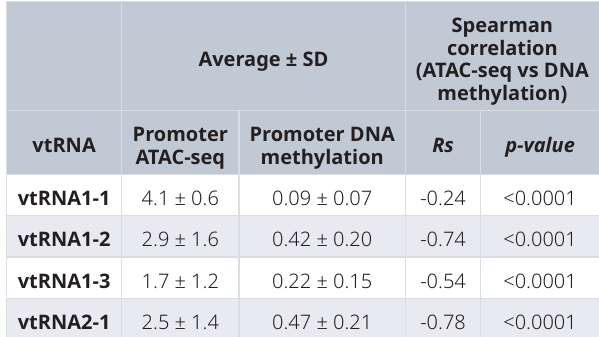
Spearman correlation (ATAC-seq vs DNA